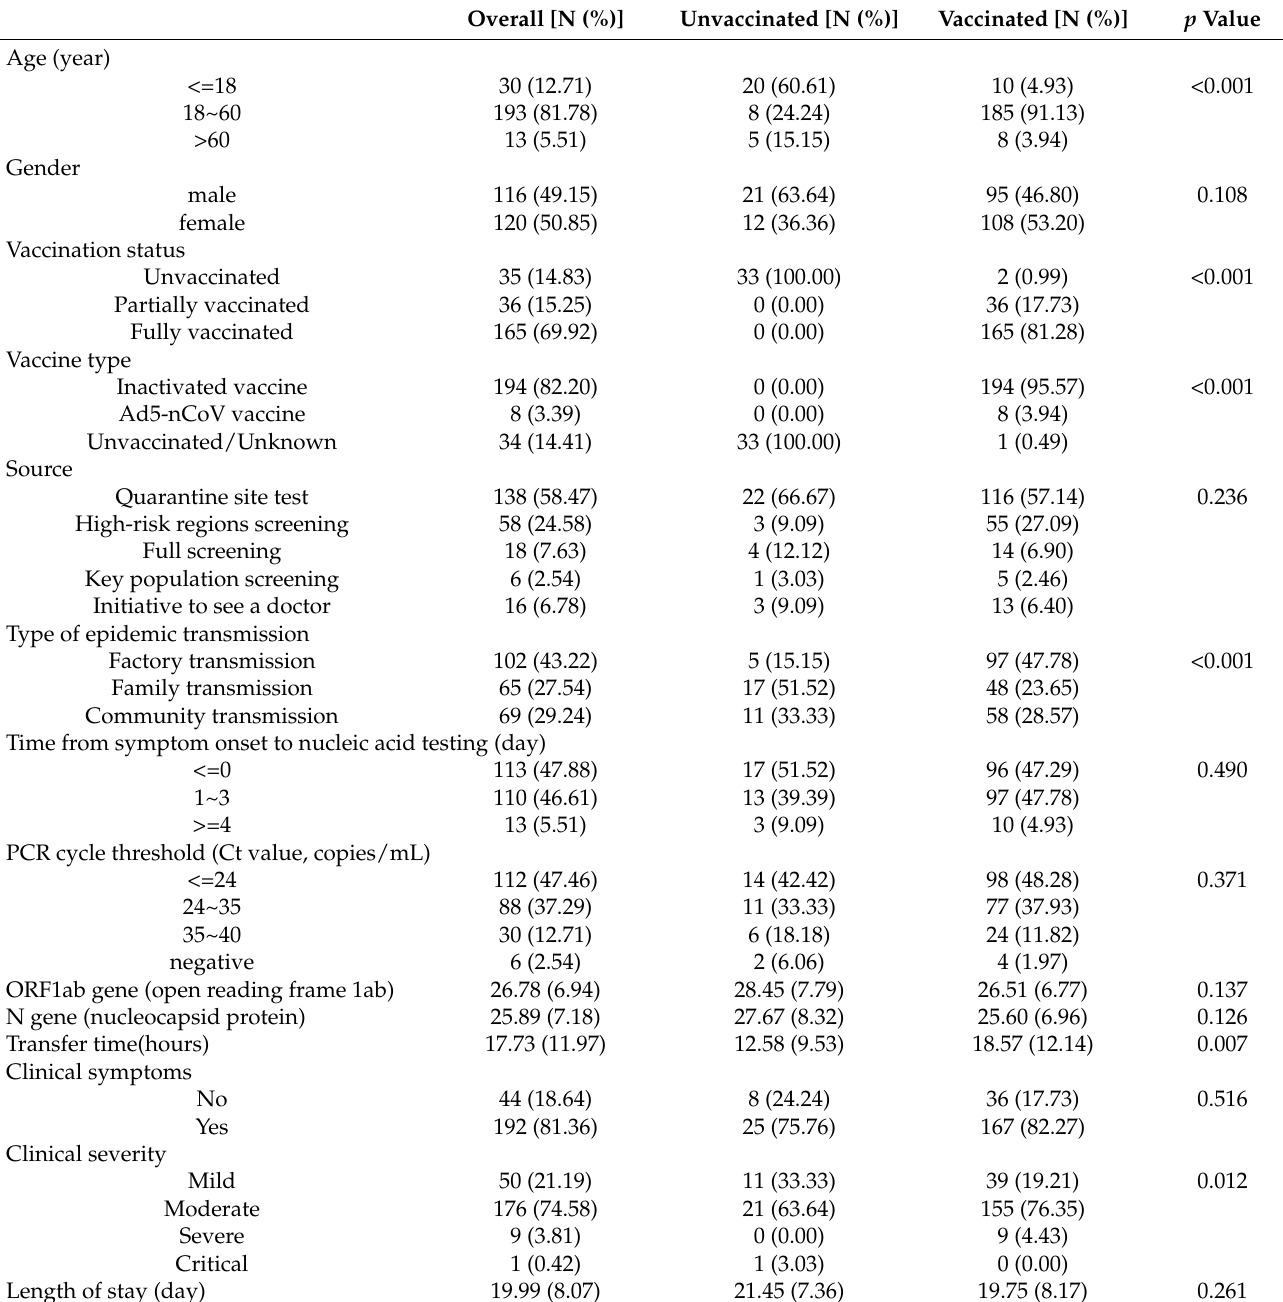
Table 1. Epidemiological Characteristics of all the cases identified in the outbreak in